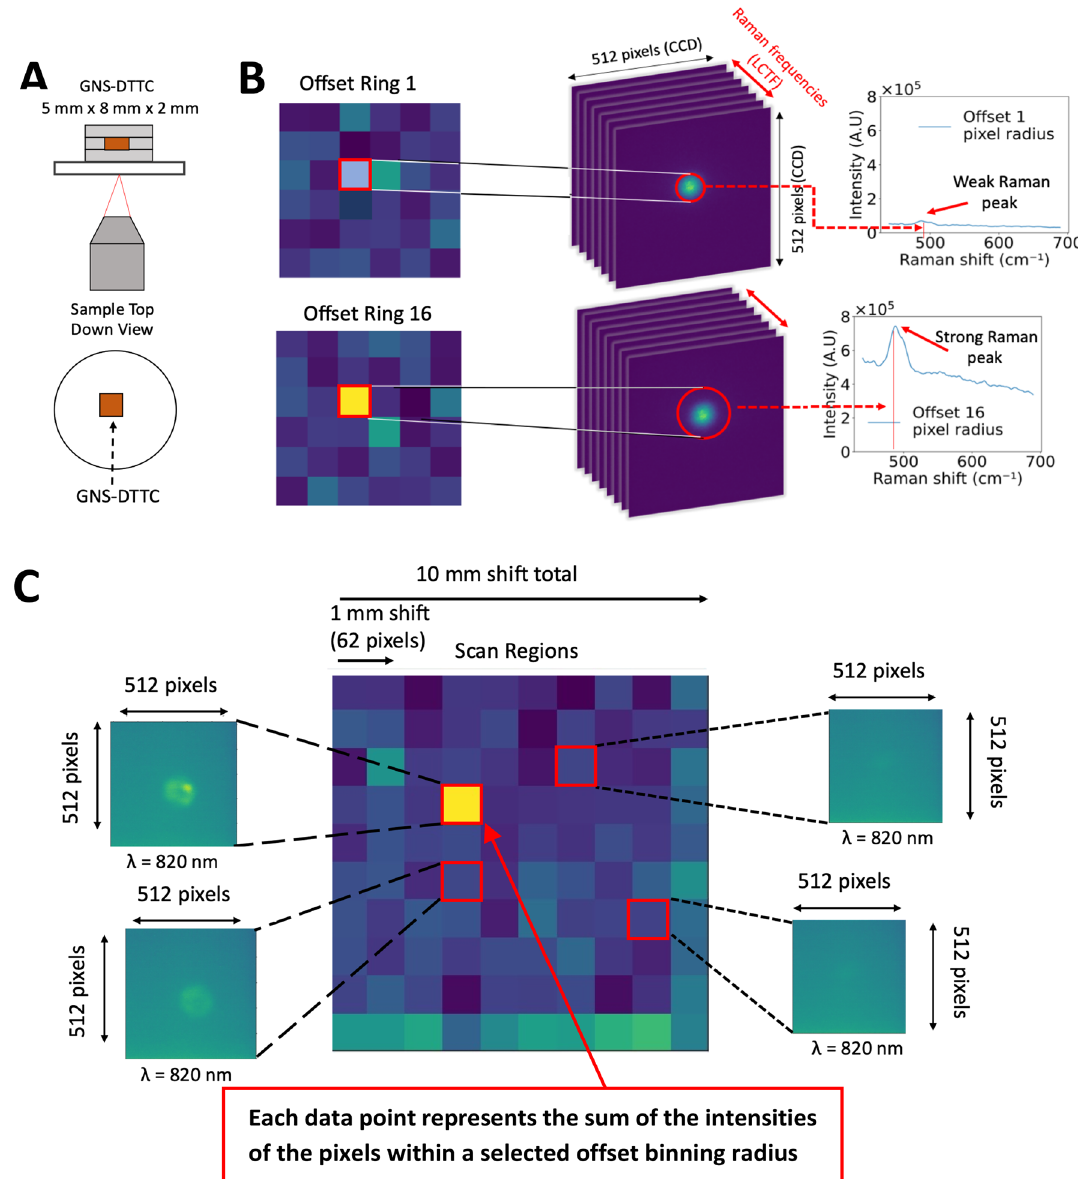
Figure 3. Demonstration of embedded single Raman layer detection with the ORCHID system. ( A ) Embedded GNS-DTTC gel sample of 2 mm thickness. ( B ) Hyperspectral imaging map of sample showing high Raman signal collection with greater spatial offset. The hyperspectral cube data is processed across different frequencies and subsequently binned and summed to produce the Raman spectra. The radially binned pixels are summed as a total intensity corresponding to a scanned location. The effect of larger radial binning shows a higher contrast for the GNS-DTTC section of the gel. ( C ) A larger spatial map showing the individual collected images at the corresponding Raman peak frequency (497 cm −1 ). The central image represents the total scanned images collected together where each data point on the image represents the sum of the spatially offset CCD image pixels corresponding to a selected binning radius. The brighter data points in the 2D image correspond to higher intensity values of GNS-DTTC